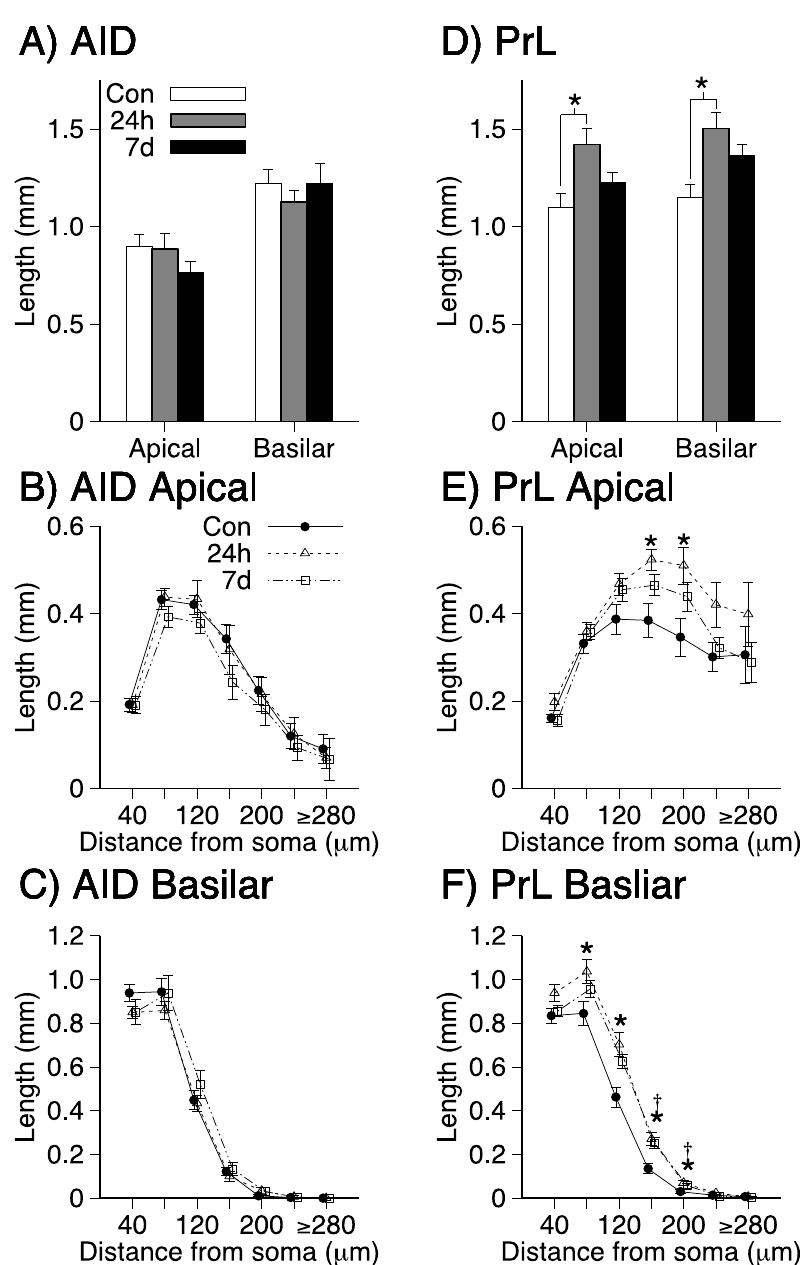
Figure 4. AID ( A – C ) mean ( + SEM) dendritic length in apical and basilar fields ( A ), mean ( ± SEM) dendritic length as a function of distance from the soma for apical ( B ) and basilar ( C ) fields; PrL ( D – F ) mean ( + SEM) dendritic length in apical and basilar fields ( D ), mean ( ± SEM) dendritic length as a function of distance from the soma for apical ( E ) and basilar ( F ) fields; (*, 24 h > Control, p < 0.05; † 7 d > Control, p < 0.05).